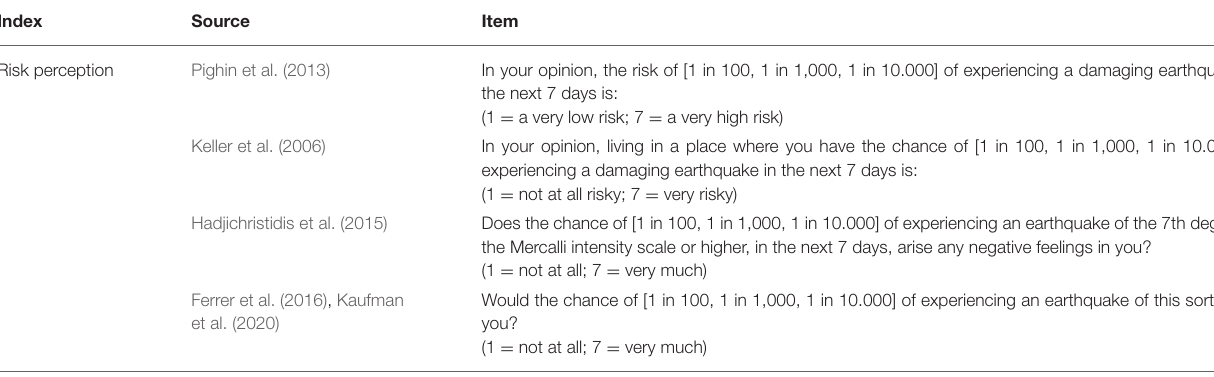
TABLE 2 | Items used in the questionnaire to measure earthquake risk perception.